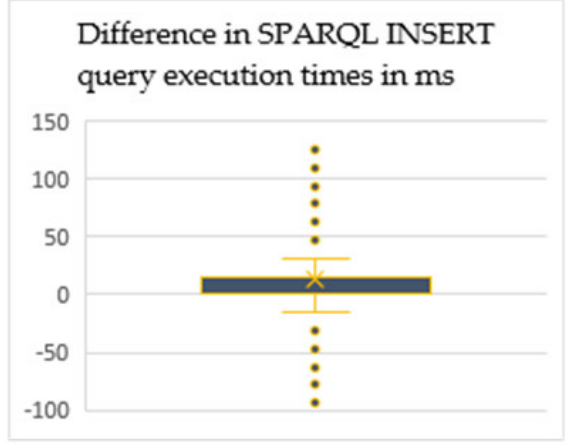
Figure 5. Box and whisker plot representing the difference in SPARQ INSERT DATA query request execution times distribution.